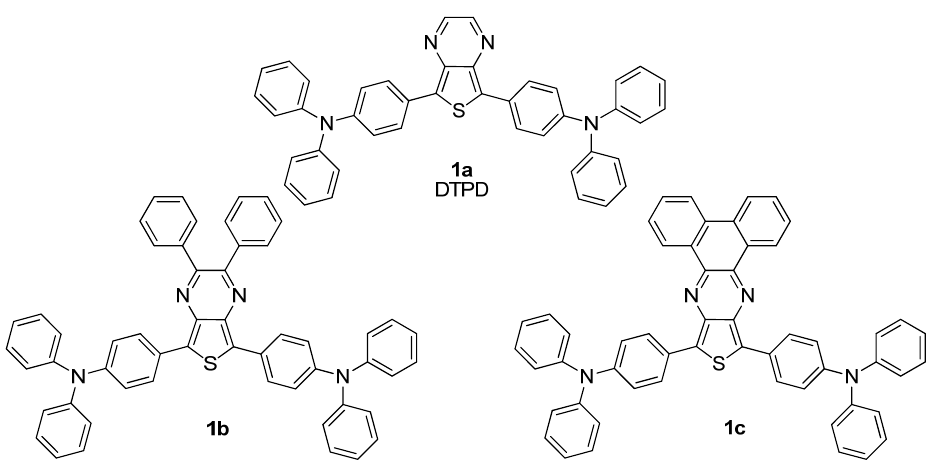
Figure 3. Structures of thienopyrazine-based dyes prepared in this work.